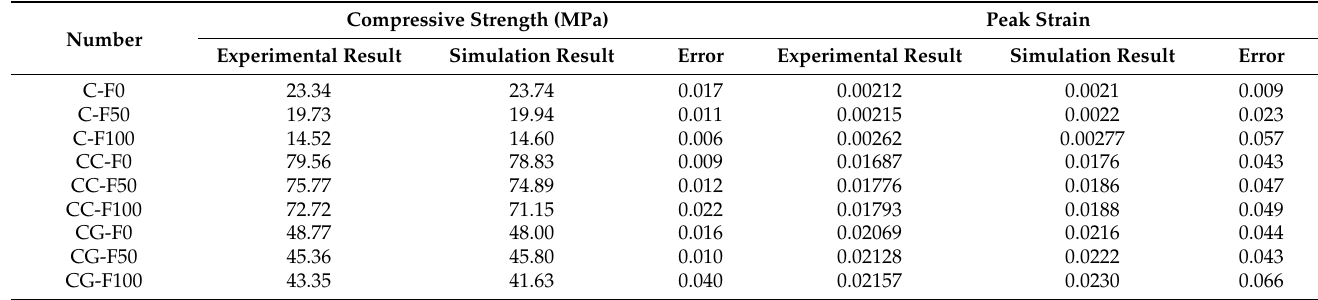
Table 7. Experimental results and numerical simulation results of the compressive test.